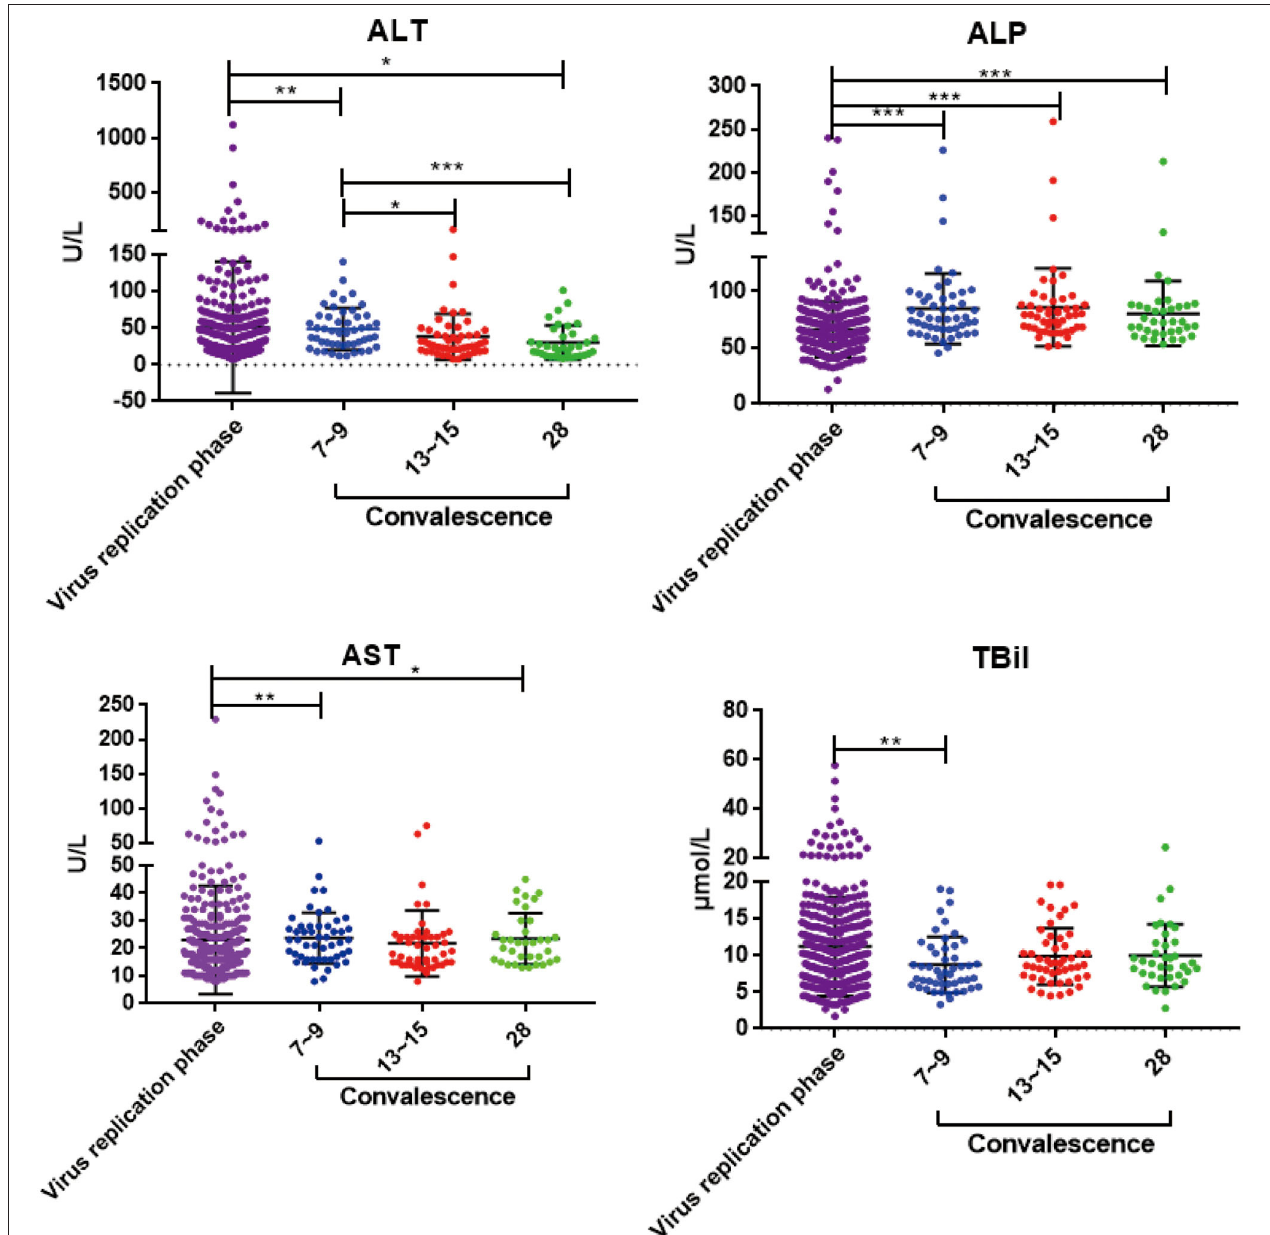
FIGURE 2 | The dynamic changes of ALT, AST, ALP, and TBiL in virus replication phase and early convalescence. Levels of significance: p -value: ***, < 0.001; **, < 0.01; *, <